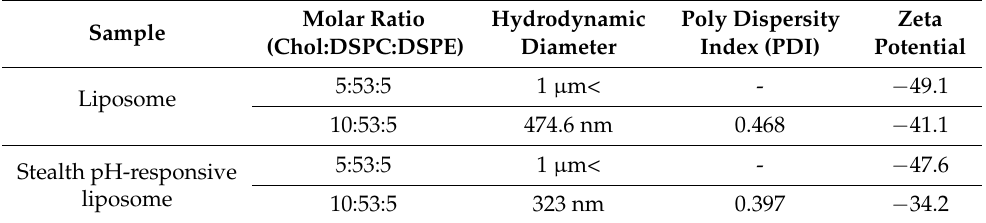
Table 2. Size and zeta potential results of different types of